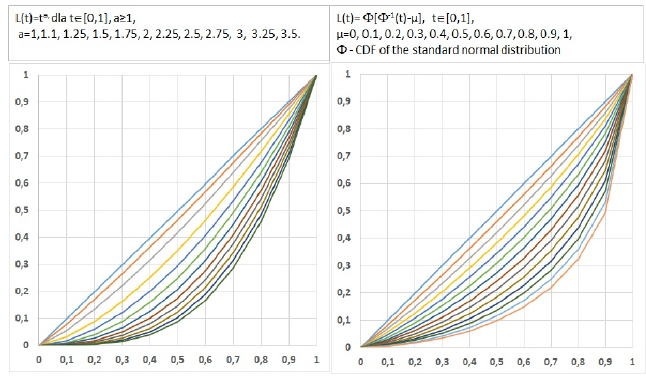
Figure 3. Lorenz curves for different L(t). Source: own study.